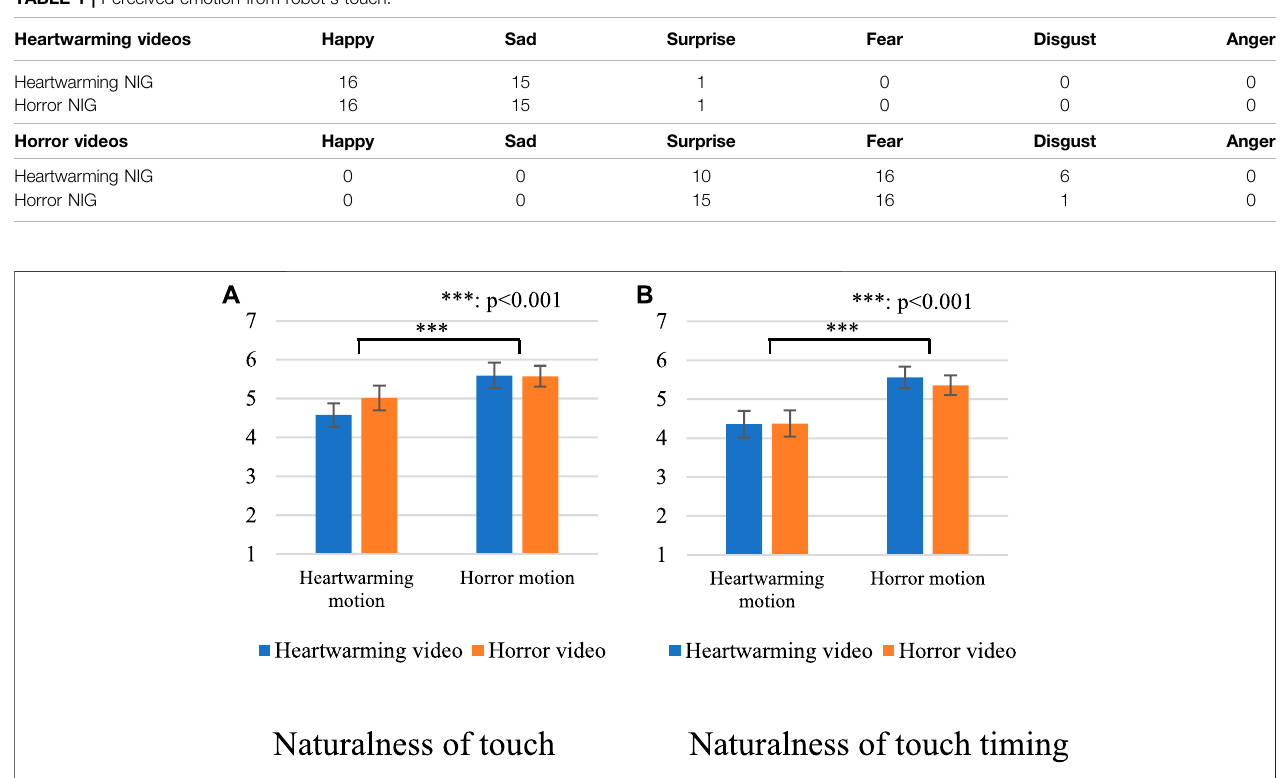
Frontiers in Robotics and AI |